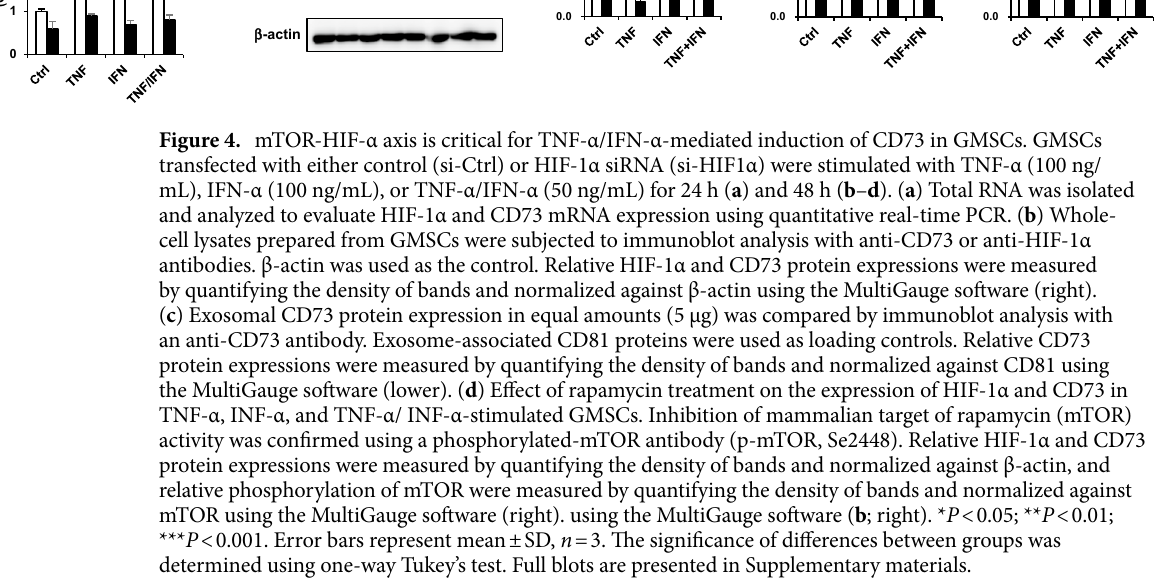
TNF/IFN) (26.8% vs. 44.7%; 1.67-fold). Conversely, CD206 expression was decreased by knockdown of CD5L in GMSC-derived EVs (EVs-siCD5L) (26.8% vs. 18.1%) and the effect of M2 activation by TNF-α and INF-α